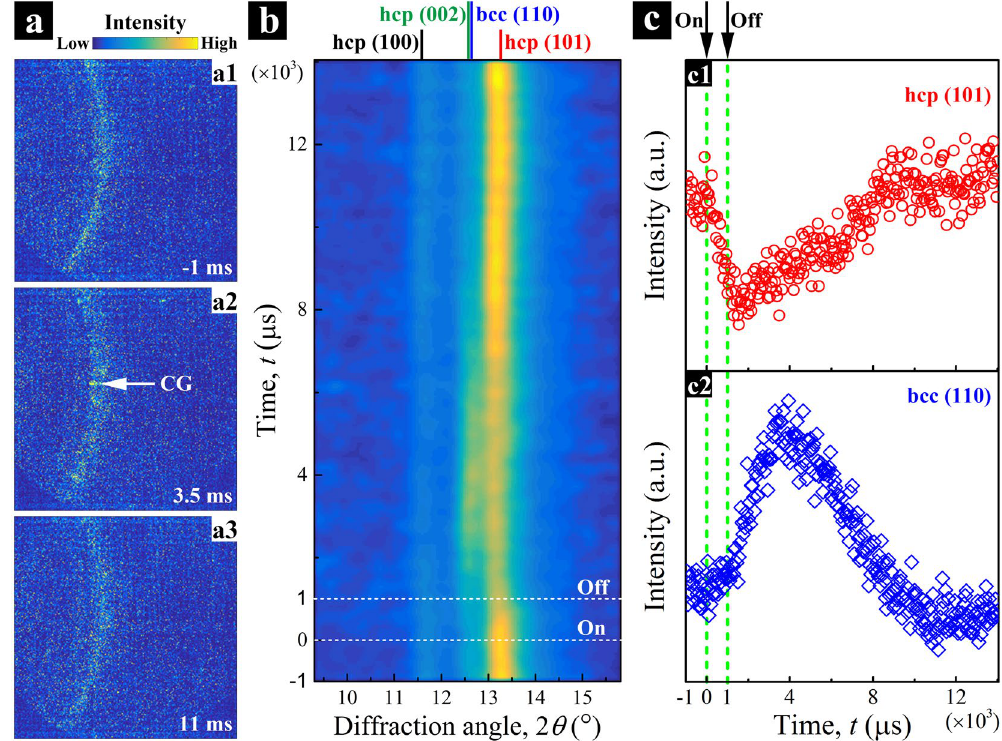
Figure 6. High-speed X-ray diffraction of Ti-6Al-4V in laser melting and solidification process. ( a ) A time sequence of three representative diffraction patterns collected at the time, t = − 1 ms, 3.5 ms, and 11 ms, respectively. The continuous diffraction rings with uniform intensity distribution in (a1) are a reflection of the starting fine α grain structure. The strong diffraction spots that appear in (a2) indicate the formation of coarse β grains (CG) in the sample; while the return to continuous rings with uniform intensity distribution in (a3) indicates a transformation back to a finer grain microstructure. ( b ) Time-resolved diffraction intensity map. ( c ) Diffraction intensities of hcp-(101) and bcc-(110) peaks. The dashed lines in ( b ) and ( c ) marked the start and end of laser